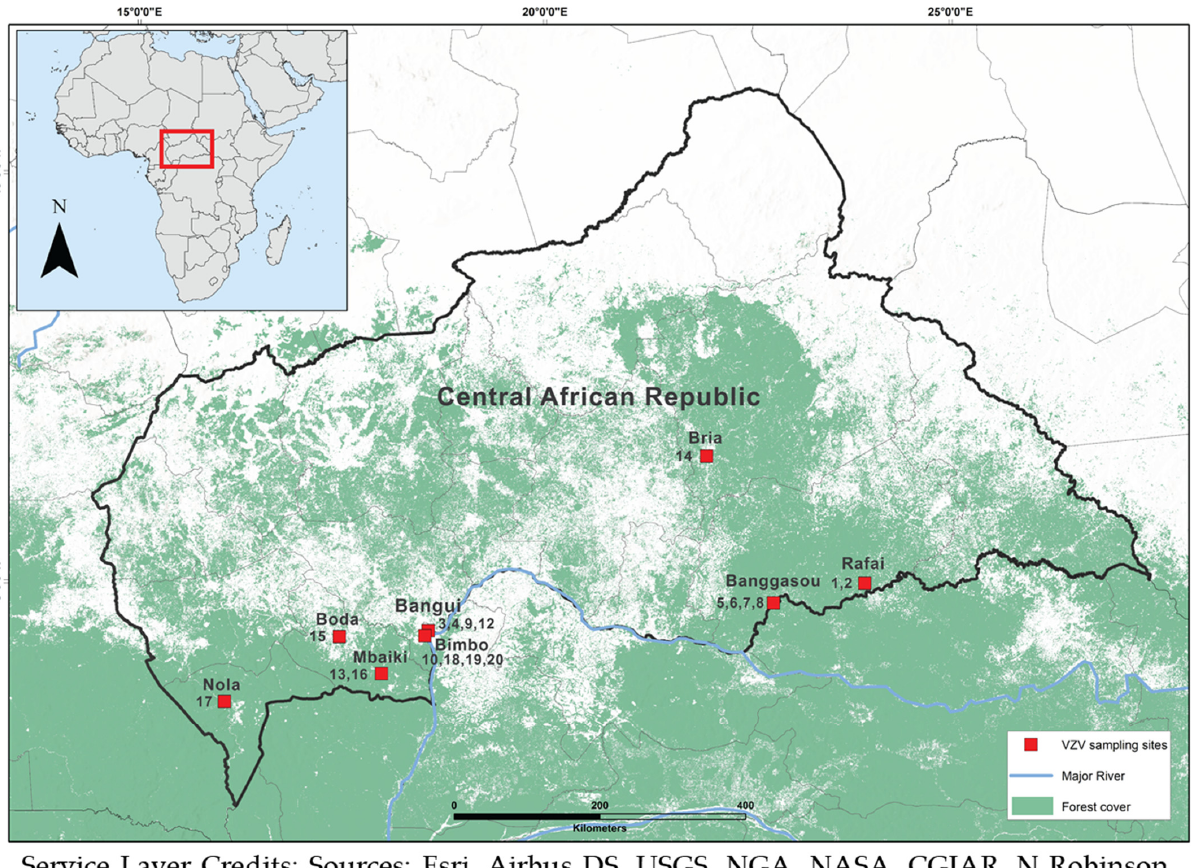
Figure 1. Sampling sites in the Central African Republic (CAR). Twenty VZV samples were collected from various locations in the CAR from 2018 to 2021.